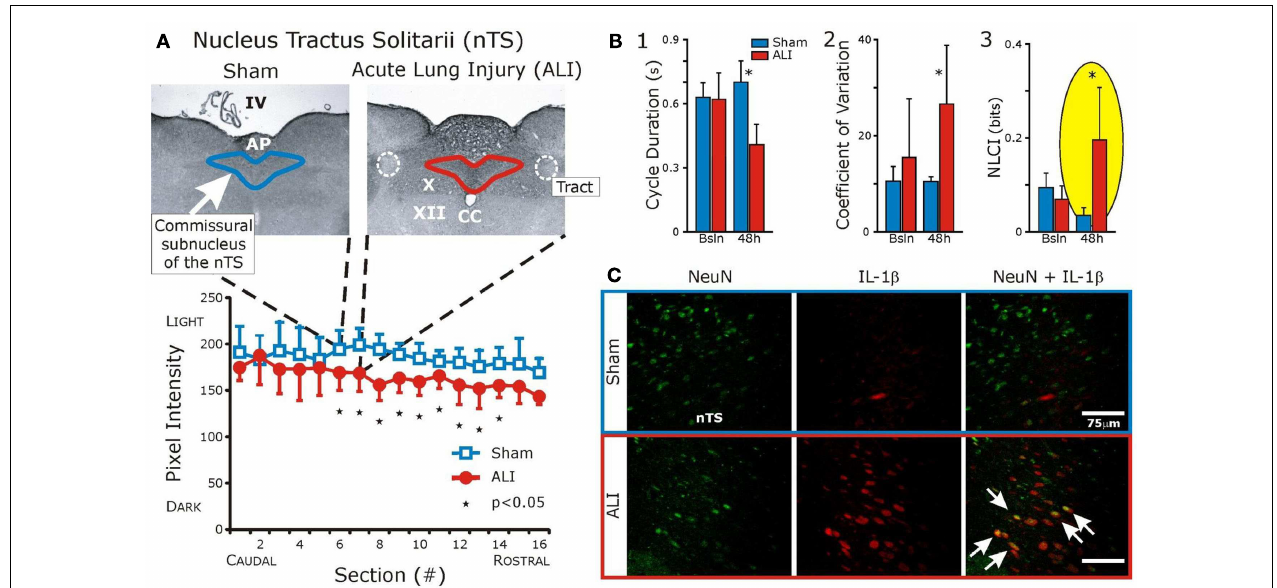
(B) Compares ventilatory patterns of sham (blue) and ALI (red) rats at baseline and 48h. After ALI: (1) Increased respiratory rate (significant decrease in cycle duration,TTOT), (2) Increased coefficient of variation (CV) of respiratory cycle length (CV ofTTOT), and (3) Increased deterministic non-linear variability of the ventilatory pattern, as measured by a non-linear complexity index (NLCI, yellow highlight) computed using surrogate data analysis. (C) Fluorescent staining: IL-1 β co-localized with nTS neurons (white arrows) identified using antibodies against the neuronal specific nuclear protein NeuN. (Adapted from; Wysocki et al.,